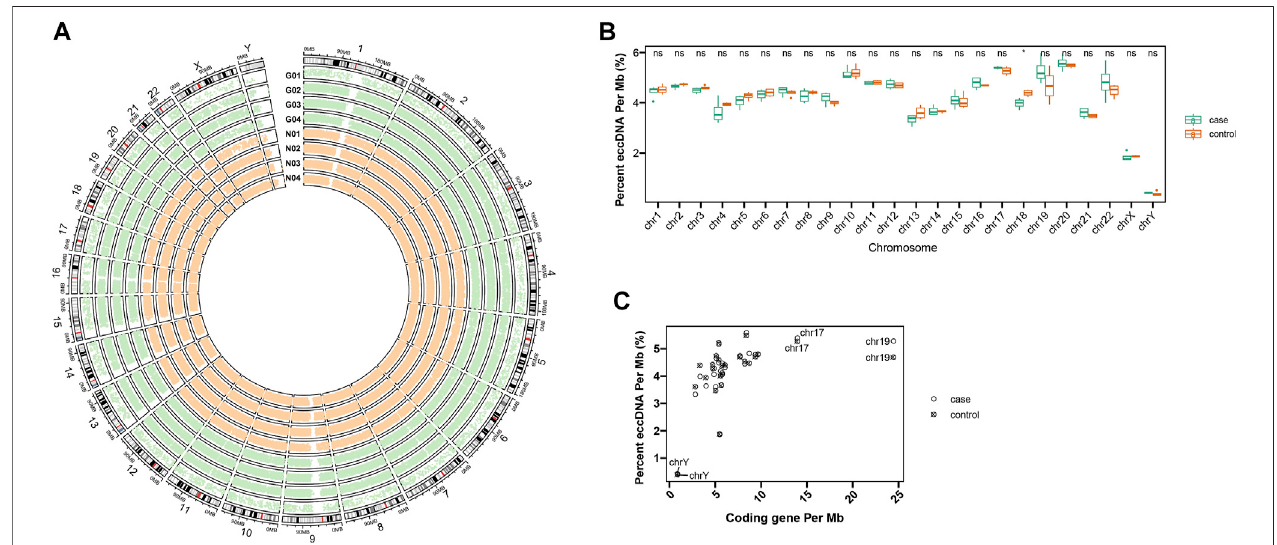
FIGURE1| DistributionofplasmaeccDNAsacrosshumanchromosomes. (A) ThecircosplotofeccDNAdistributionsfromfouracutegoutpatients(G01-G04)and four healthy controls (N01-N04). (B) The eccDNA distributions of gout and control on each chromosome. Ns stands for there are no signi fi cant differences of eccDNA distribution between control and gout group. * shows there are signi fi cant differences of eccDNA distribution between control and gout group on chromosome 18. (C) The frequency of eccDNAs per Mb and coding genes per Mb on each chromosome.